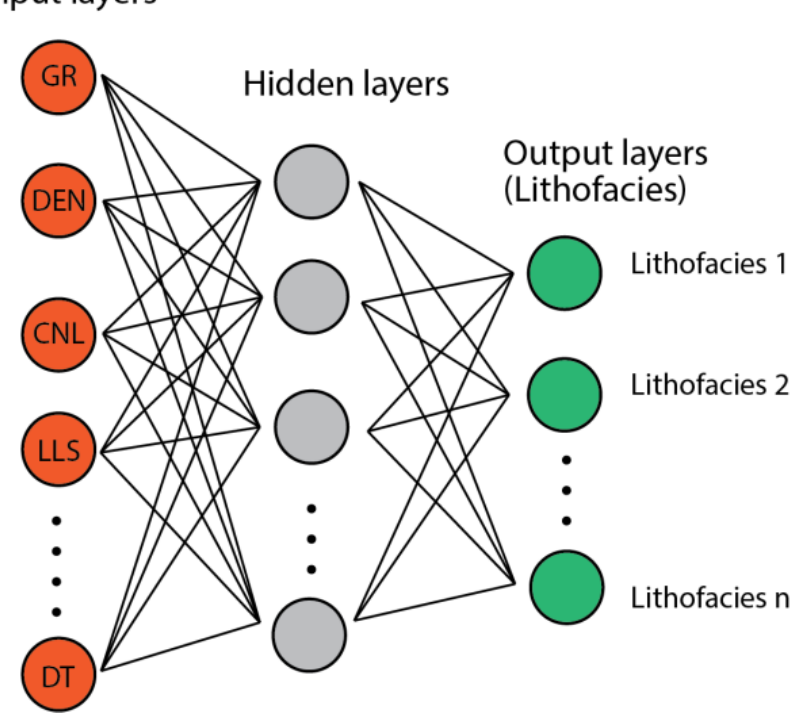
Figure 7. A Multilayer Perceptron (MLP) schematic diagram where inputs stand for well logs and outputs represent different lithofacies.